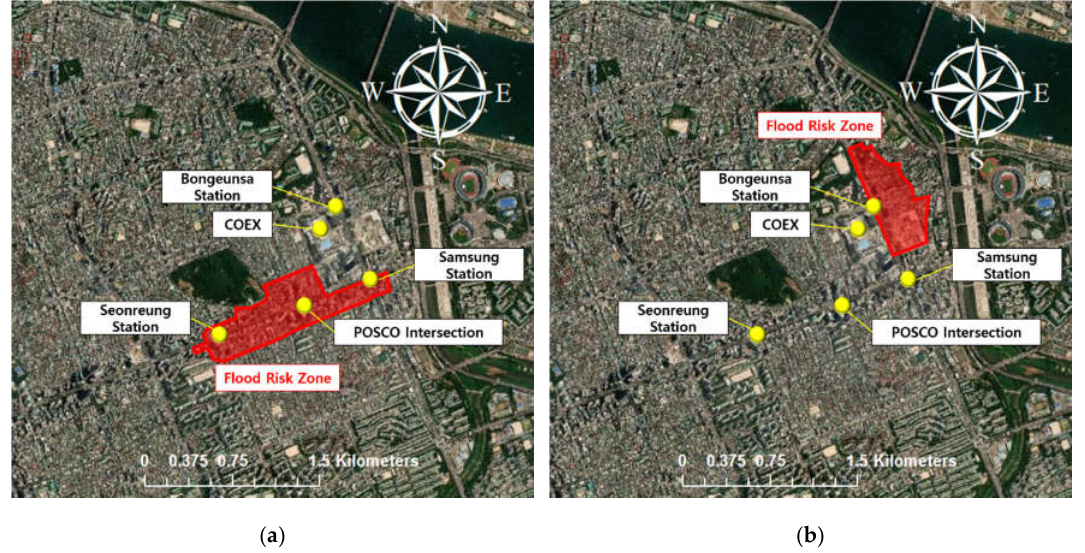
Figure 4. Flood hazard zone in Samsung‐dong. ( a ) shows Samsung–Seonreung Station, and ( b ) shows Bongeunsa–Samsung Station.